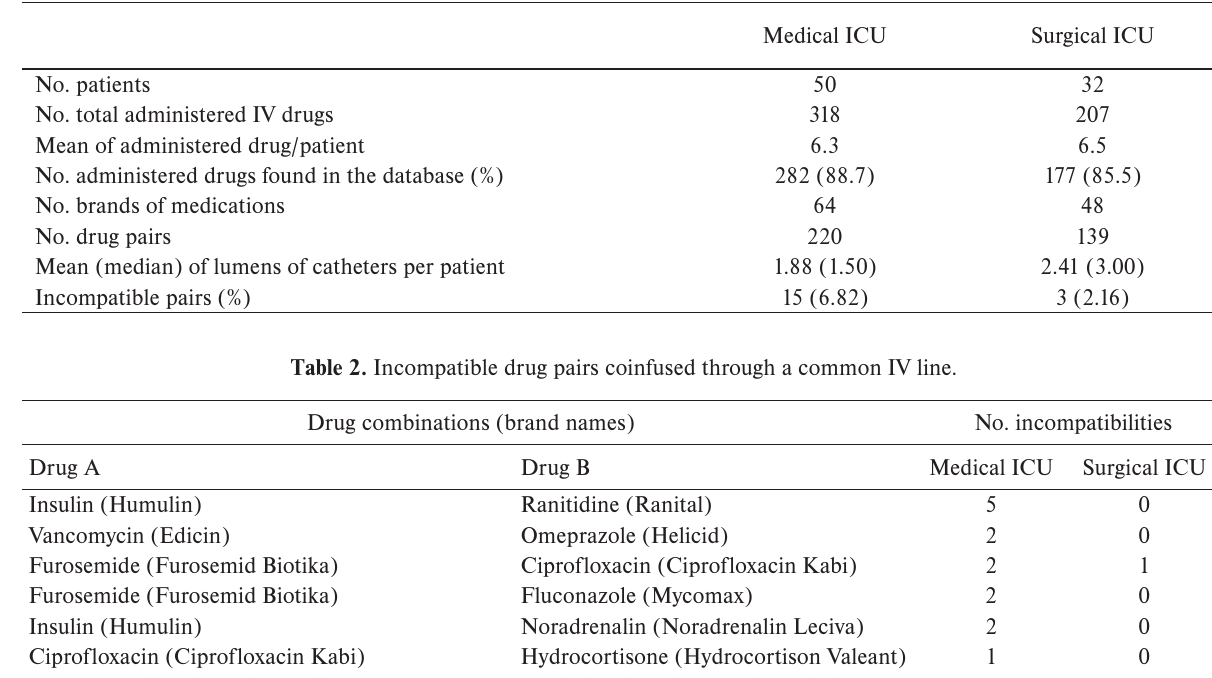
Table 1. Results of our study.